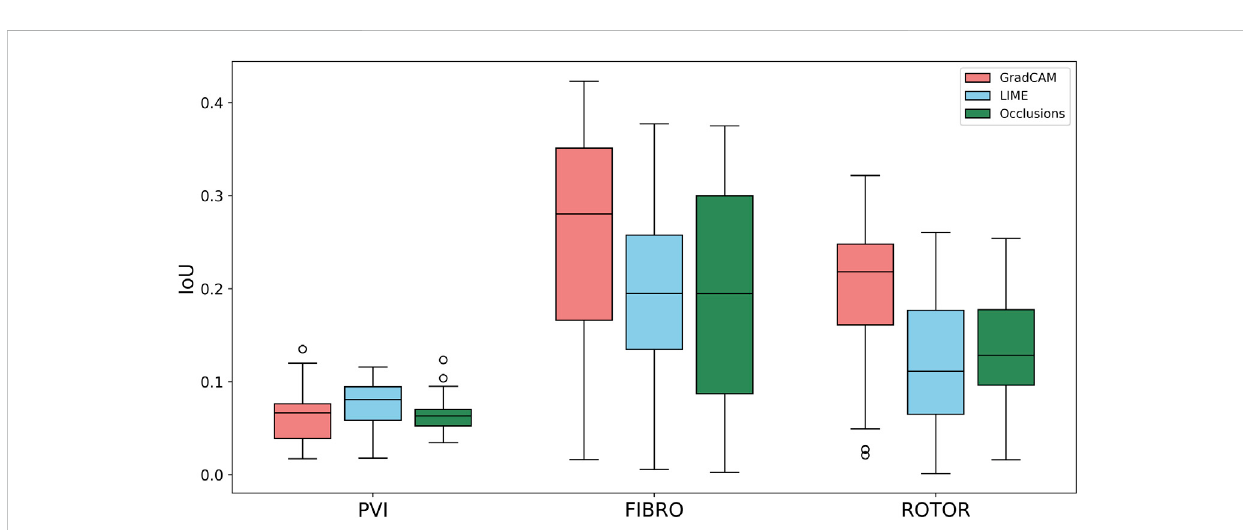
FIGURE 4 Boxplot of Jacquard index (IoU) for each FA method (GradCAM, LIME and Occlusions) and RFCA strategy (PVI, FIBRO and ROTOR) on the hold-out test